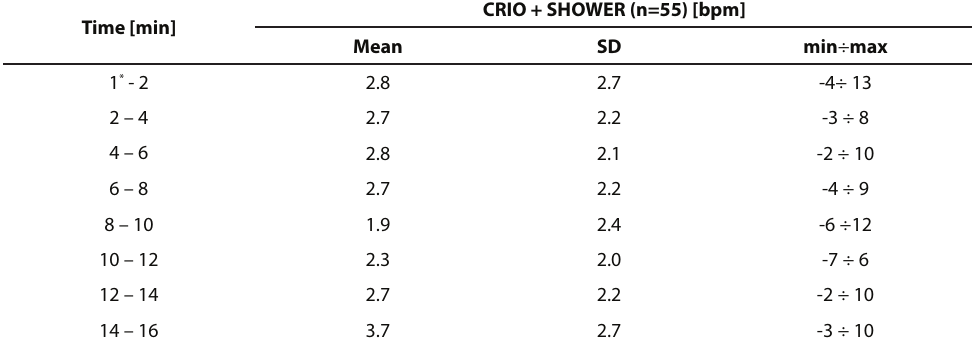
TABLE 4. Changes in heart rate during sauna at one-minute intervals (up to the 16 th minute) CRIO + SHOWER (n=55) Time [min]